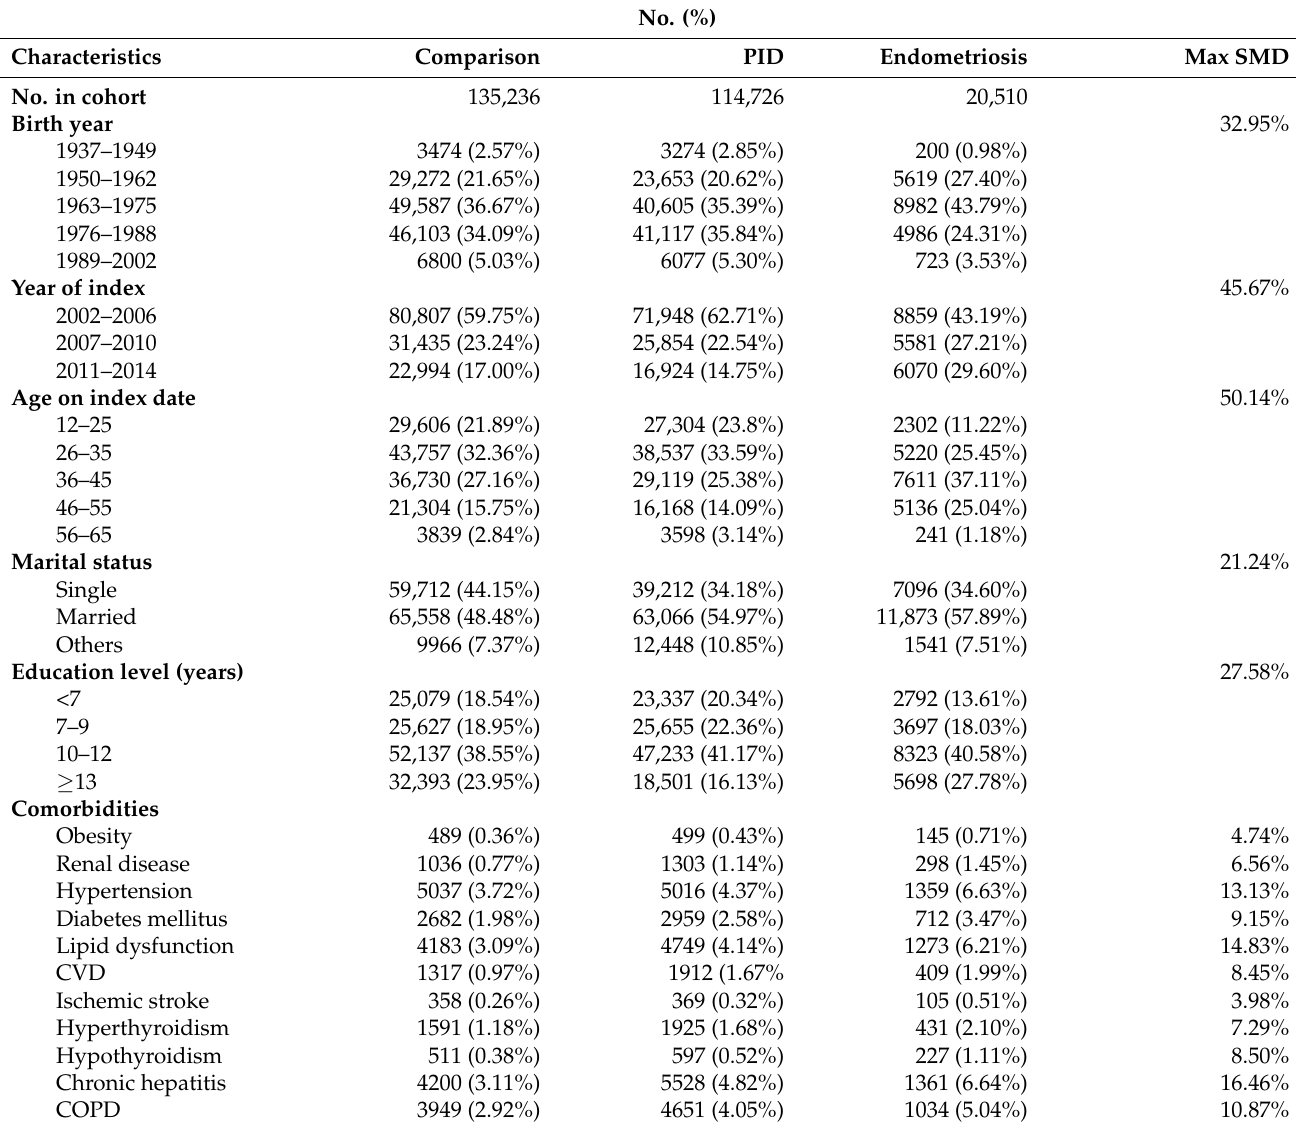
Table 1. Characteristics of exposure (pelvic inflammatory disease or endometriosis) cohort and age matched comparison